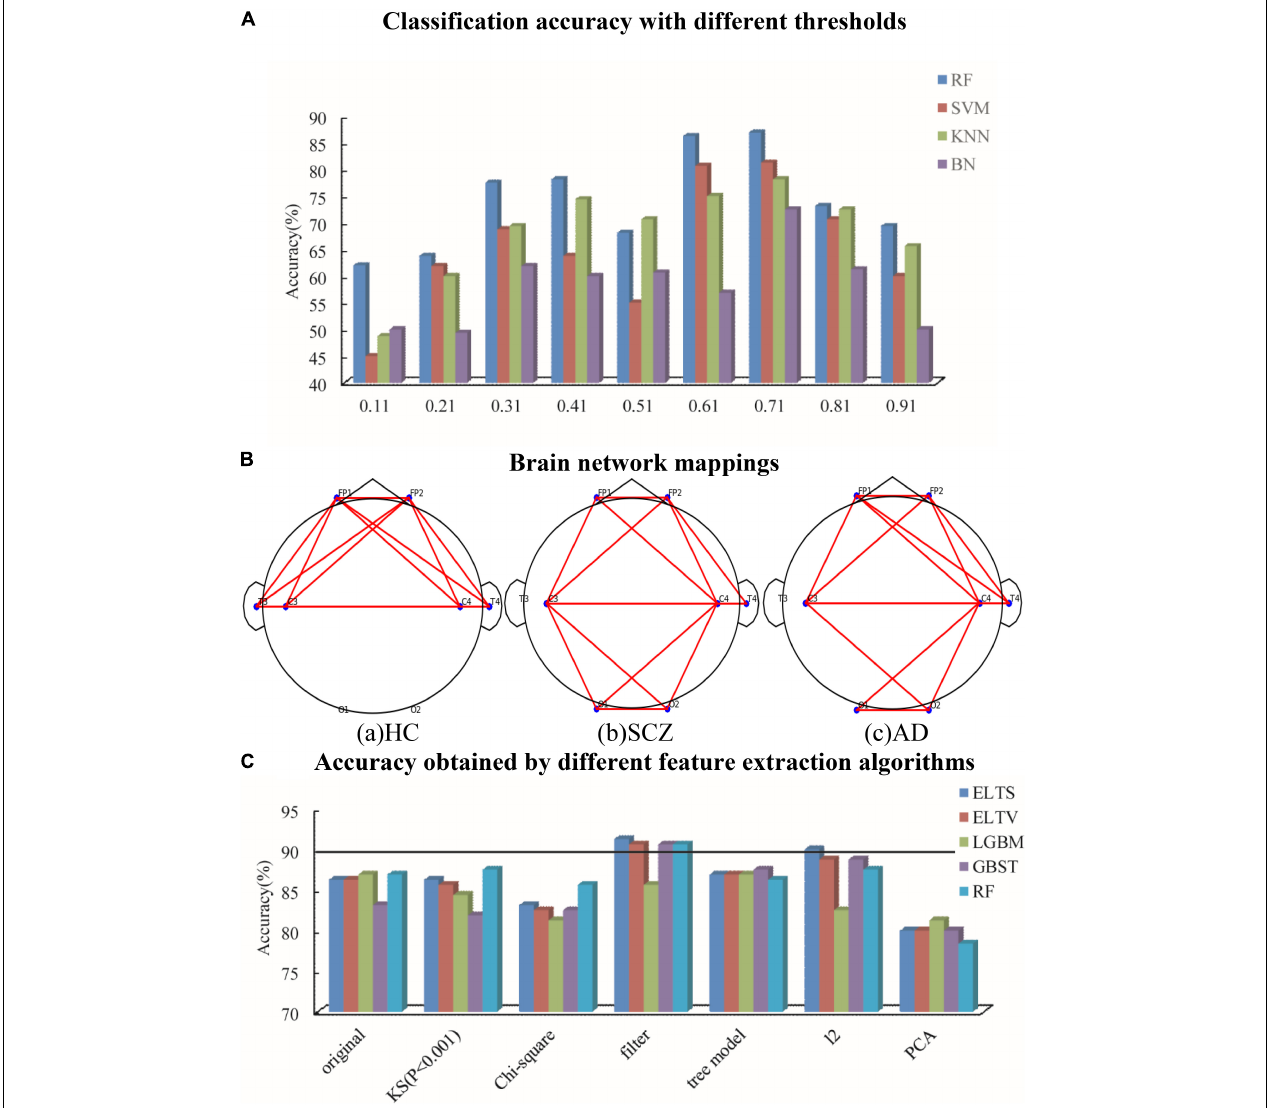
FIGURE 3 | To find the best thresholds and features, it is classified for different threshold values and different feature selection methods. (A) Classification accuracy with different thresholds. (B) Brain network mapping. (C) Accuracy obtained by different feature extraction